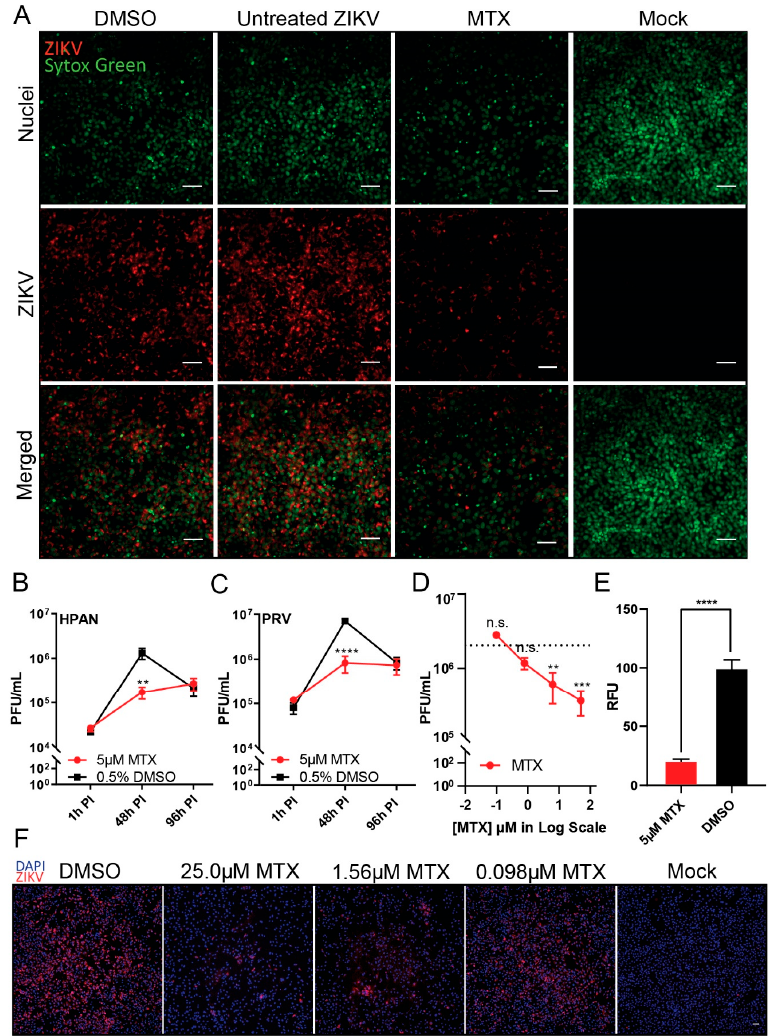
Figure 1. Inhibition of Zika virus (ZIKV replication in Vero Cells after methotrexate (MTX) treatment. ZIKV-infected Vero cells were treated with 5 µ M MTX or 0.5% of DMSO as a negative control. ( A ) Immunofluorescence images (20X) of ZIKV-infected (H/PAN/2016/BEI-259634, NR-50210 strain (H/PAN), multiplicity of infection (MOI) 0.2) Vero cells were acquired to analyze the level of ZIKV-envelope protein after 5 µ M MTX treatment at 48 h post-infection (PI). SYTOX green was used to stain nuclei of Vero cells. Scale bars represents 5 µ m. The virus titer of two ZIKV strains, ( B ) H/PAN MOI 0.2 and ( C ) PRVABC59, NR-50240 strain ZIKV (PRV) MOI 0.2, were measured after 5 µ M MTX treatment at three different time points, 1 h PI, 48xh PI, and 96 h PI. ( D ) ZIKV titer after MTX treatment in dose-response manner (8-fold, 50 µ M, 6.25 µ M, 0.781 µ M, and 0.0977 µ M) from ZIKV-infected (H/PAN MOI 0.2) Vero cells at 48 h PI. ( E ) Average cytoplasm fluorescence signal of ZIKV-envelope protein per nuclei from ZIKV-infected (H/PAN MOI 0.2) Vero cells with 5 µ M MTX treatment was measured at 48 h PI. RFU = relative fluorescence units. ( F ) Immunofluorescence images (10 × ) of ZIKV-infected (H/PAN MOI 0.2) Vero cells with three different MTX concentrations (6-fold dilution series, 25.0 µ M, 1.56 µ M, 0.098 µ M) were acquired to observe the reduction in ZIKV-envelope protein’s fluorescence signal at 48 h PI. The scale bar represents 50 µ m. For (E) and (F), DAPI was used to stain nuclei of Vero cells. At least two independent replicates were performed. For (B) and (C), two-way ANOVA, followed by Sidak’s multiple comparisons test, were used for statistical analysis. For (D), one-way ANOVA, followed by Tukey’s multiple comparisons test, were used for statistical analysis; average viral titer at each MTX concentration was compared to that of untreated ZIKV at 48 h PI as a control. For ( E ), Student’s t-test was used for statistical analysis (two-tailed distribution, heteroscedastic). Error bars represent standard error of the mean (SEM). ** p ≤ 0.01, *** p ≤ 0.001, **** p ≤ 0.0001, n.s. not